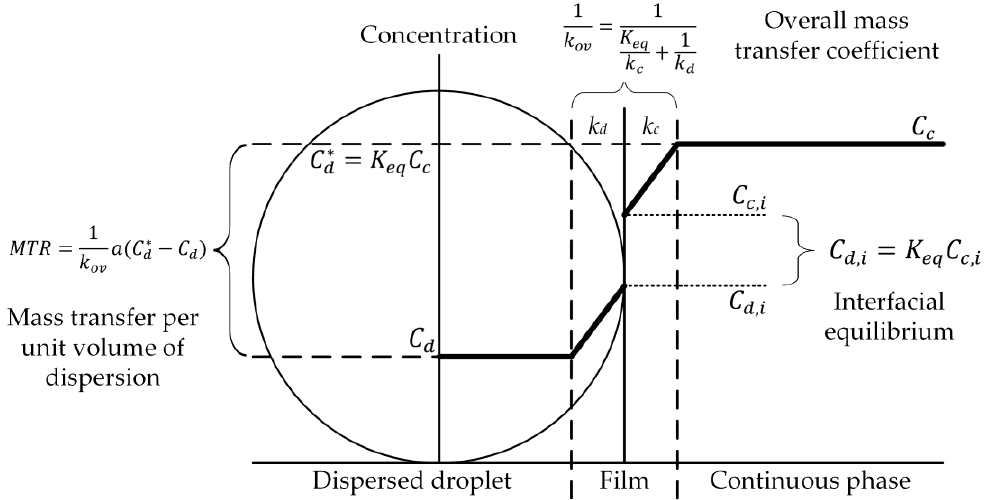
Figure 2. Schematic representation of two-film theory.